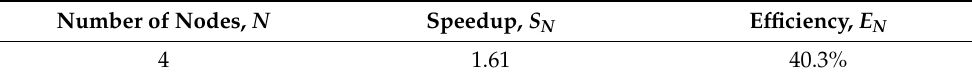
Figure 2. The speedup ( S , red) and the efficiency ( E , green) of the parallelization depending on the number of computing nodes ( N ) for the oPMEC algorithm; the maximum possible speedup is indicated by a blue dashed line. Table 1. Speedup and parallelization efficiency for the oPMEC algorithm. Number of Nodes, N